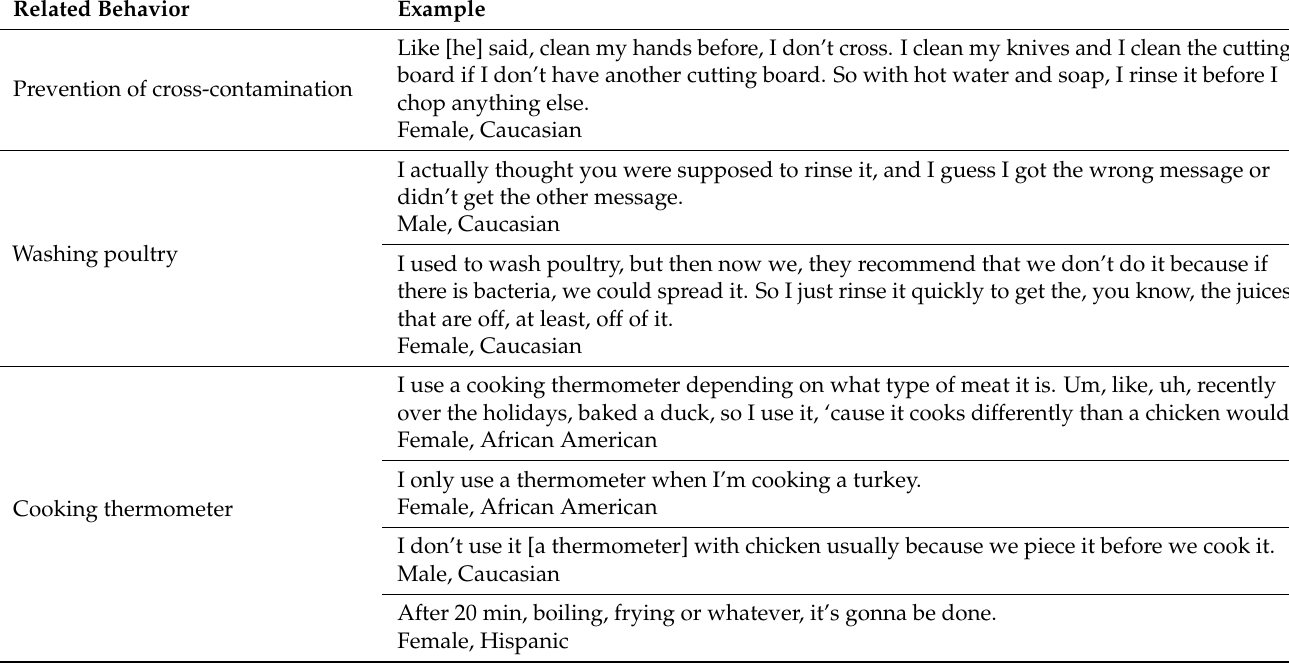
Table 2. Food handling behaviors related to poultry, with supporting quotes from the focus group